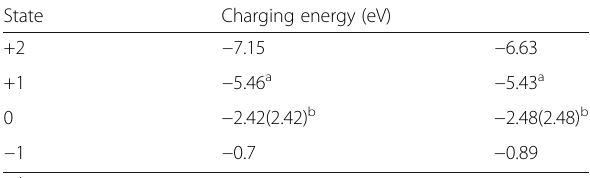
Table 2 Charging energy E N – 1 – E N of different charge states of indigo and Tyrian purple molecules in the SET environment